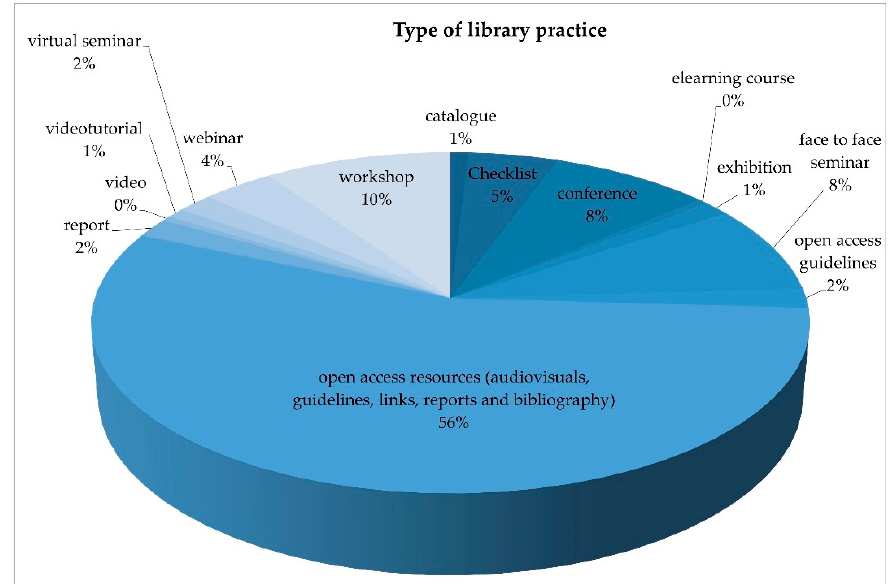
Figure 2. Type of library practice. Source: prepared by the authors. To classify these practices, their titles were also considered. Some examples are listed in Table 1: Table 1. Libraries’ practice name.